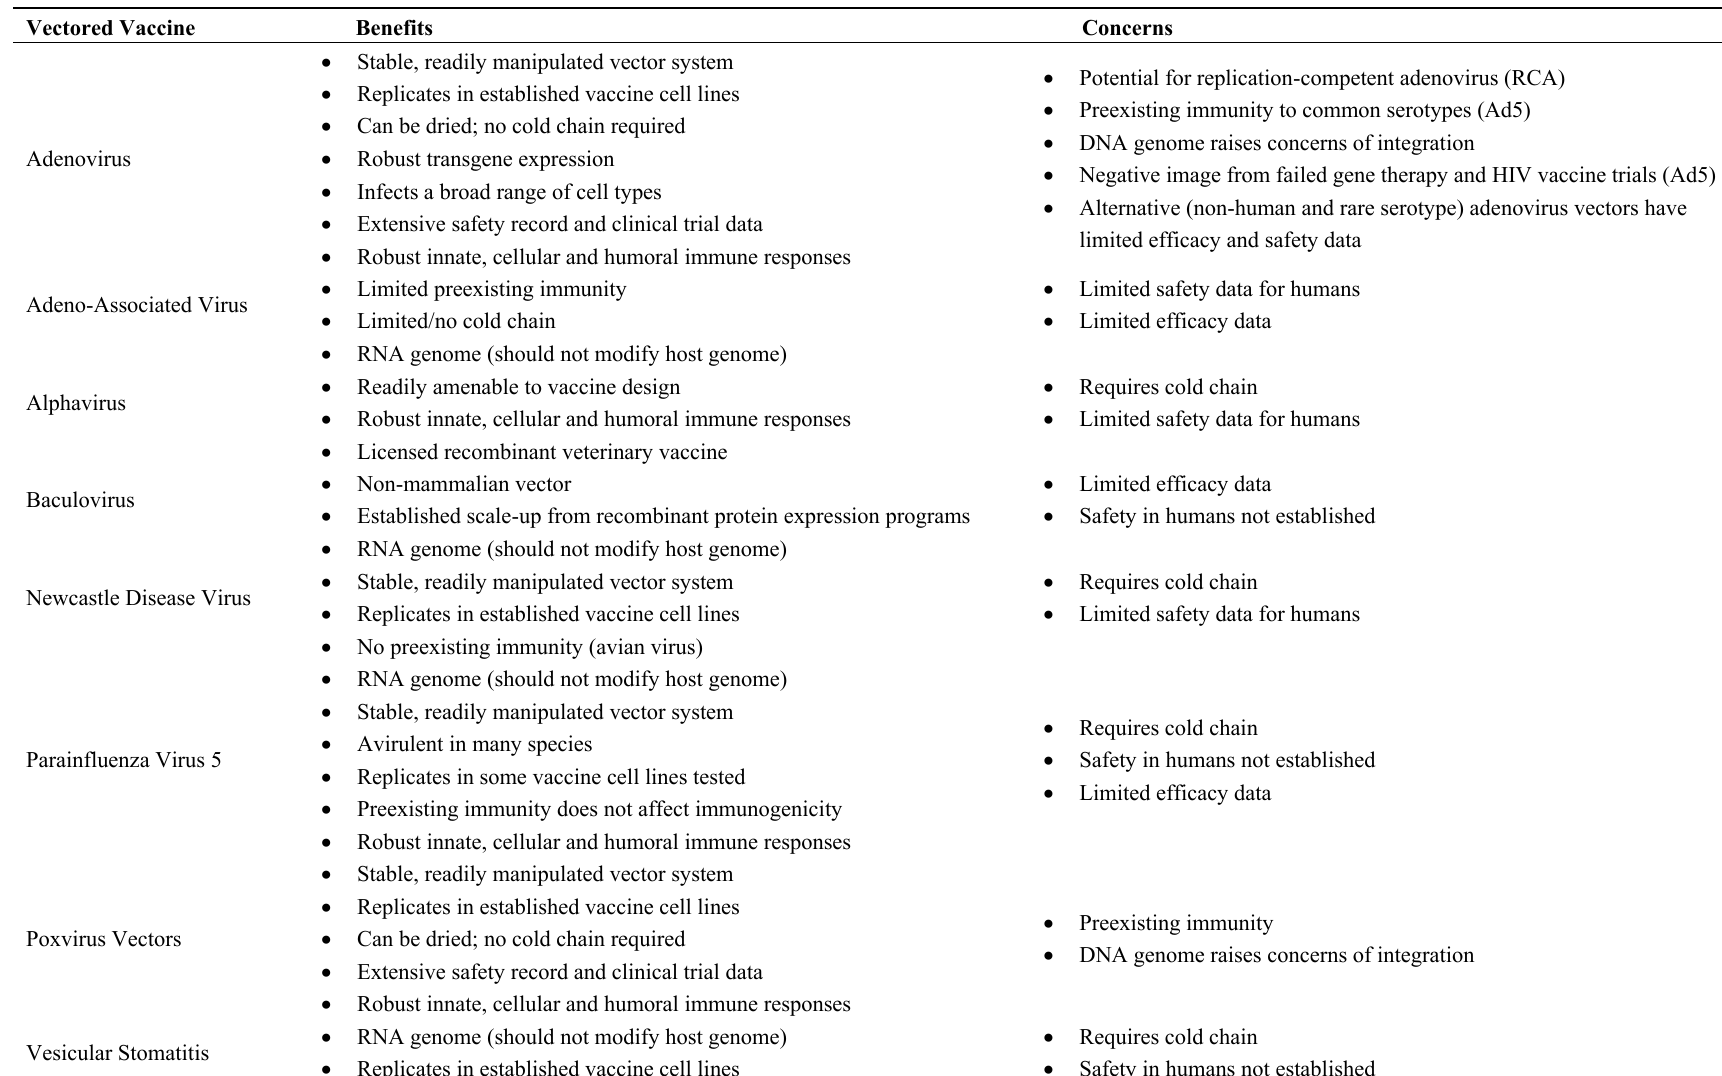
Table 1. Virus-vectored experimental influenza